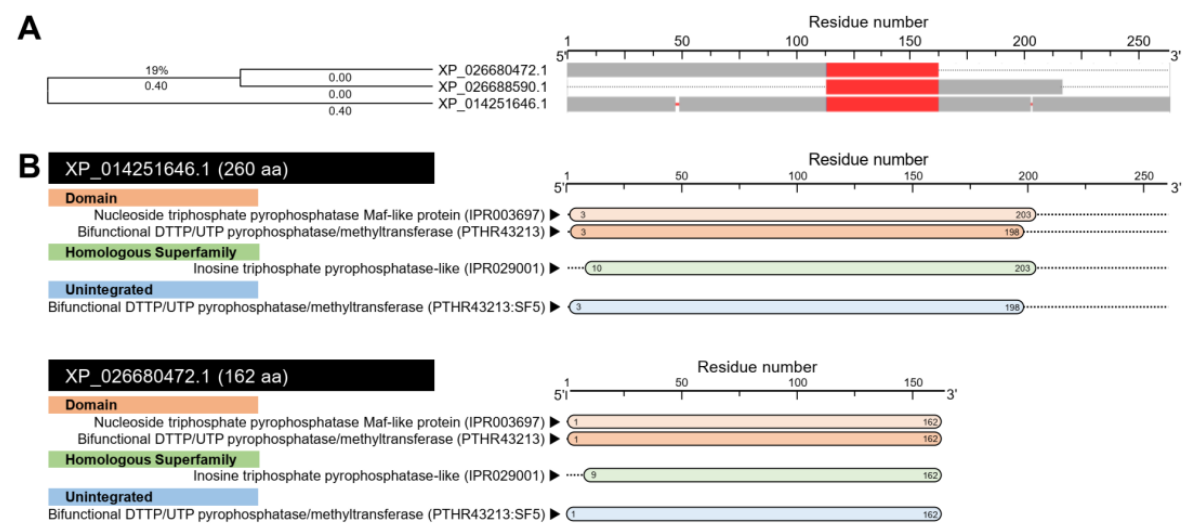
Figure 11. In silico analysis of N -acetylserotonin O-methyltransferase ( DcASMT ) of Diaphorina citri . ( A ) Evolutionary analysis using maximum likelihood method and its associated multiple protein sequences alignments using Constraint- Based Alignment tool (COBALT) analysis. The AA sequences were identified using the Protein–Protein BLAST (BLASTp) using N -acetylserotonin O-methyltransferase-like protein, isoform X1 ( ClASMT ; GenBank Accession no. XP_014251646.1) from bed bug ( Cimex lectularius ) as a query sequence, against Diaphorina citri genome available in GenBank, the national center for biotechnology information website (NCBI, http://www.ncbi.nlm.nih.gov/gene/, 12 February 2021). The tree is drawn to scale, with branch lengths measured in the number of substitutions per site (next to the branches). The proportion of sites where at least one unambiguous base is present in at least 1 sequence for each descendent clade is shown next to each internal node in the tree. Evolutionary analyses and the joint tree were conducted in MEGA-X software. In the COBALT analysis, residues were colored using a column-based method according to their relative entropy threshold. Aligned columns with no gaps are colored blue and red, where the red color indicates highly conserved columns and blue indicates less conserved ones. ( B ) The protein functional and conserved domains analysis of ClASMT (XP_014251646.1) and DcASMT (XP_026680472.1) using the InterPro Scan tool (https://www.ebi.ac.uk/interpro/, 12 February 2021).